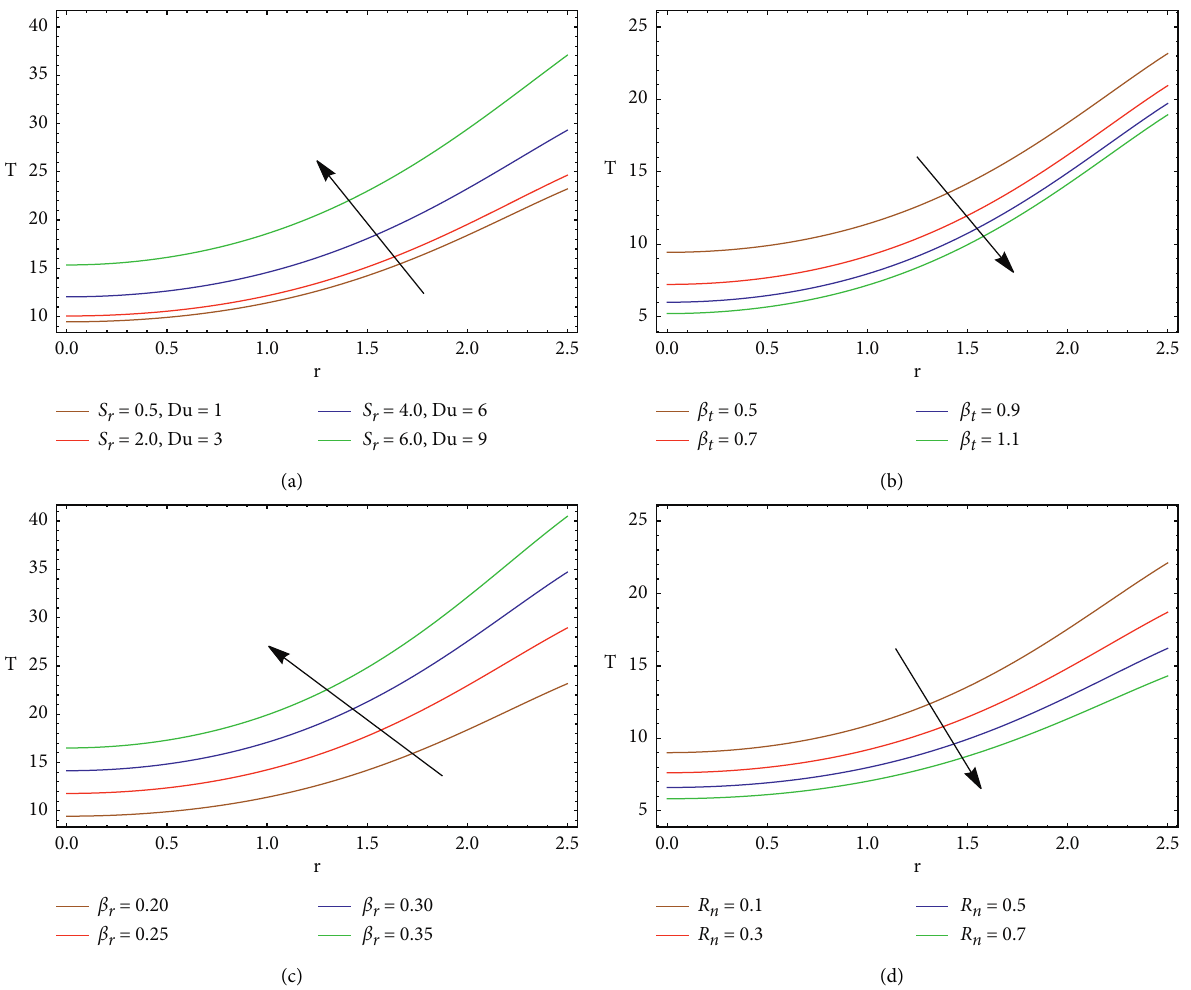
Figure 4: The variation of the temperature distribution T ( r ) for different values of D